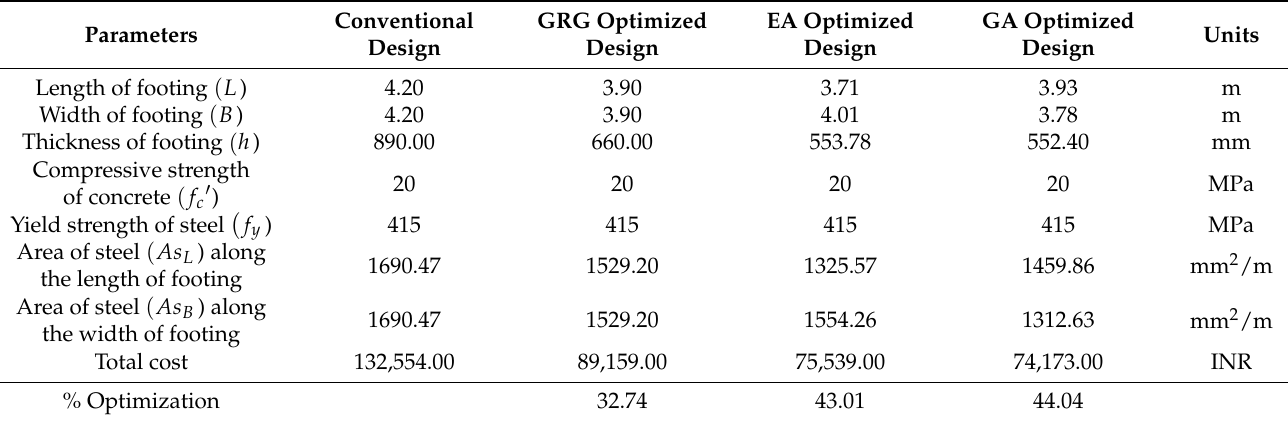
Table 5. Optimum values obtained for example 2.